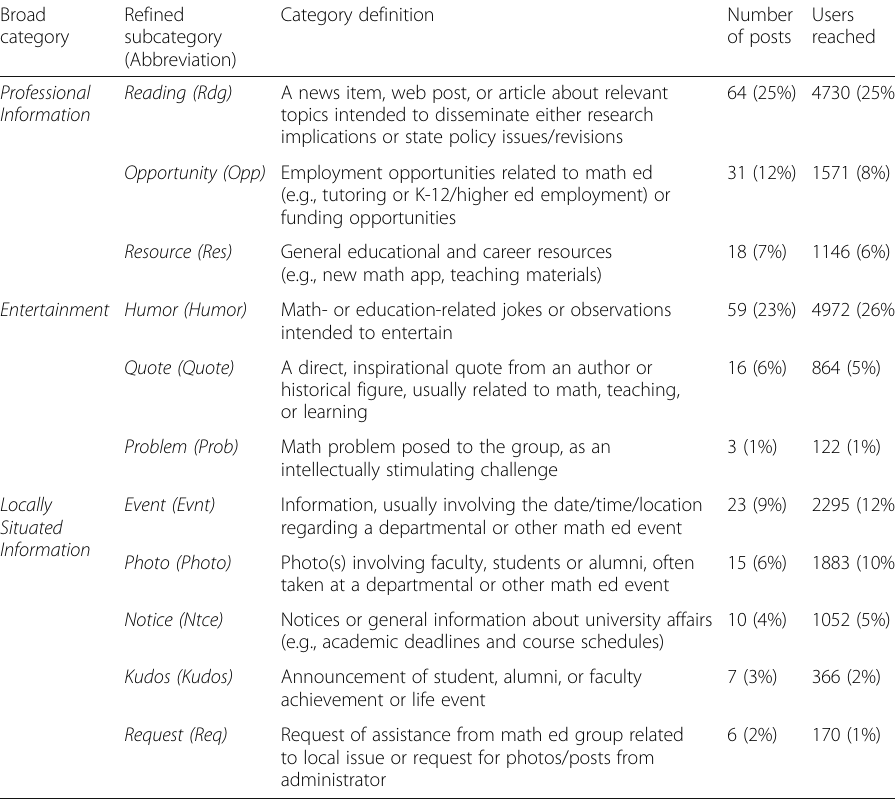
Table 1 Number of posts and users reached by Thematic content categories Broad